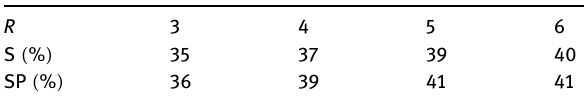
temperatures ( R = 5 )